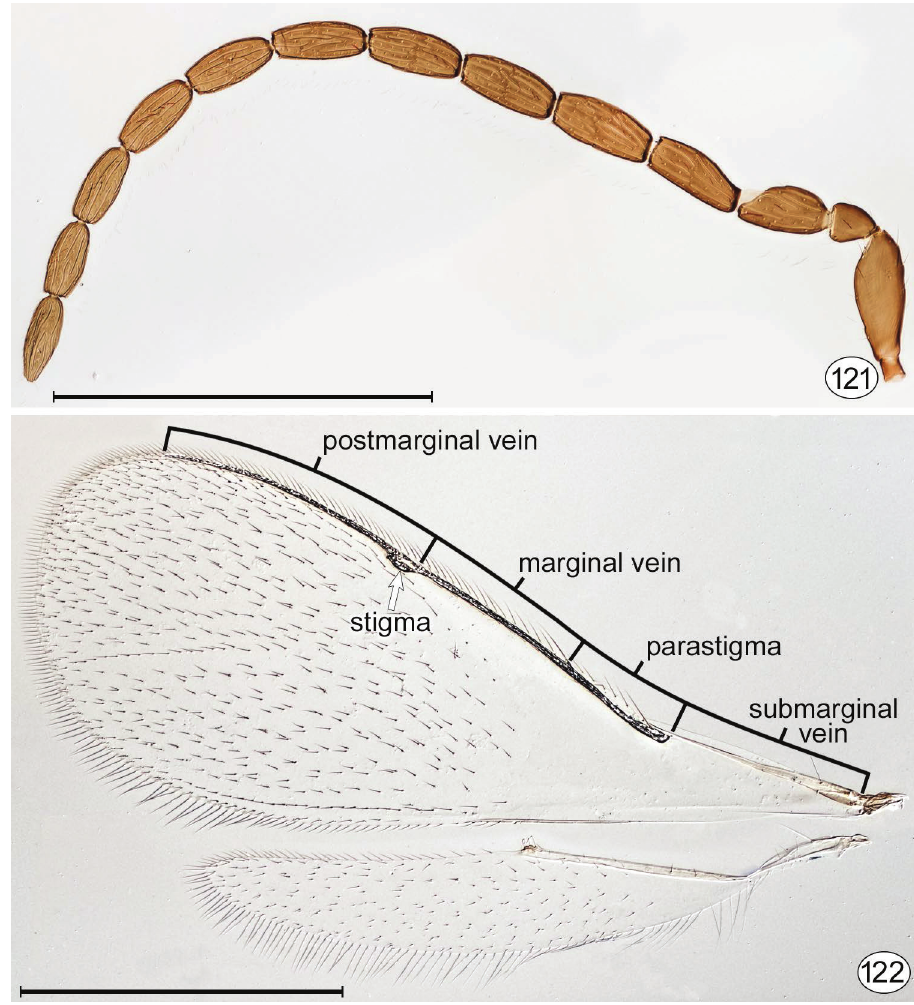
Figures 121, 122. Neotriadomerus longiovipositor . 121 male antenna, paratype (14 km W. by N. Hope Vale Mission) 122 wings. Scale bar = 500